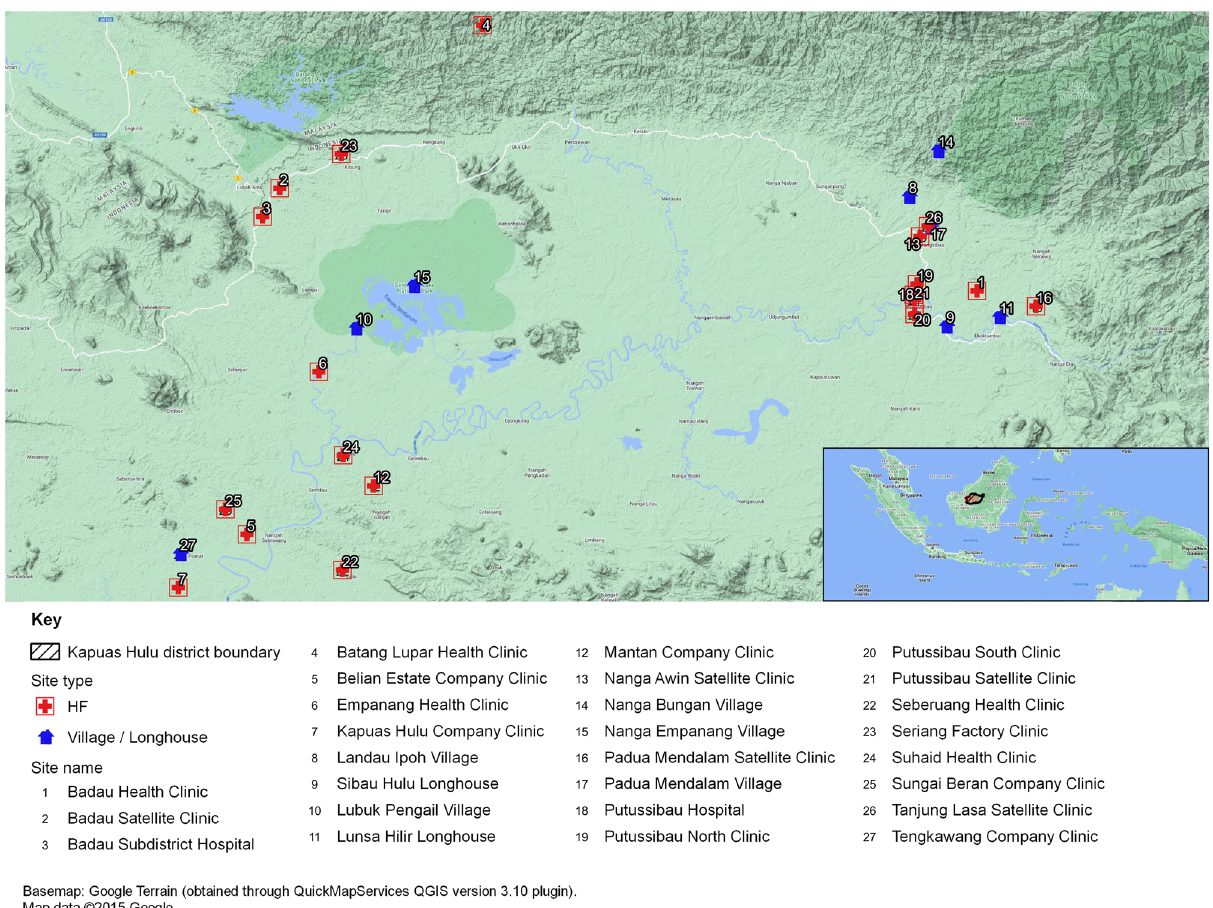
Figure 2. Health clinics and hospitals in Kapuas Hulu district where participants in the present study were screened for but the majority were adults of working age. The proportions of males and females were similar. Approximately one third were plantation workers and farmers from relatively high-risk malarious areas in the district. A third had fever or a recent history of fever. Compared to those who were afebrile, this sub-group was younger with proportionately more children and males. Although they were also less likely to be plantation workers and farm- ers, this may have reflected the larger numbers of people attending peripheral health care facilities for general health checks rather than because of symptoms. There were four participants diagnosed with malaria at the recruitment site but with negative PCR (see Table 2), two with a positive RDT (one P. falciparum and one mixed P. falciparum/P. vivax ) and the other two with a positive blood slide (one P. falciparum and one P. vivax ). All were adults who presented with fever. Five cases, four of whom presented with fever and three of whom had an RDT which was negative, were positive by PCR and the infecting species was identified (two cases of P. vivax and two of P. ovale , and one case of P. malariae ). Two of these cases were children and one an infant aged 6 months—all of these cases were febrile when recruited. There were 11 cases, six of whom had fever, who were Plasmodium -positive by PCR but the species could not be identified by PCR assays with primers specific for P. falciparum. P. vivax, P. malariae, P. ovale, P. knowlesi, P. cynomolgi, P. inui, P. fieldi and P. coatneyi. We further characterized these 11 samples by amplifying the partial small subunit ribosomal RNA (SSU rRNA) genes and generating 233–234 base pair (bp) and 272–294 bp ampli- cons with two different pairs of Nest-2 PCR primers for direct sequencing. Analysis of the DNA sequences, after the PCR primer sequences were removed, was based on the Basic Local Alignment Search Tool (BLAST) from the National Center for Biotechnology Information (NCBI) database revealed the presence of Plasmodium spe- cies , with high sequence similarity to human and simian Plasmodium species ( P. knowlesi, P. inui, P. fieldi and P. coatneyi ) for seven of the 11 cases (see Table 3). However, the identity of the infecting Plasmodium species could not be inferred through phylogenetic analyses since the DNA sequences generated were relatively short, resulting in phylogenetic trees with low bootstrap values (see Supplementary Fig. 1). None of the 11 cases were diagnosed and treated for malaria at the time of recruitment since RDTs and microscopy were not done or were negative. Of the 16 PCR positive cases, there were four who presented at the Batang Lupar Health Clinic in the north of the survey area and another 11 at sites around Putussibau Hospital in the east, both areas close to the border with Sarawak, with only a single case in the west at the Belian Estate Company Clinic (see Fig. 3).